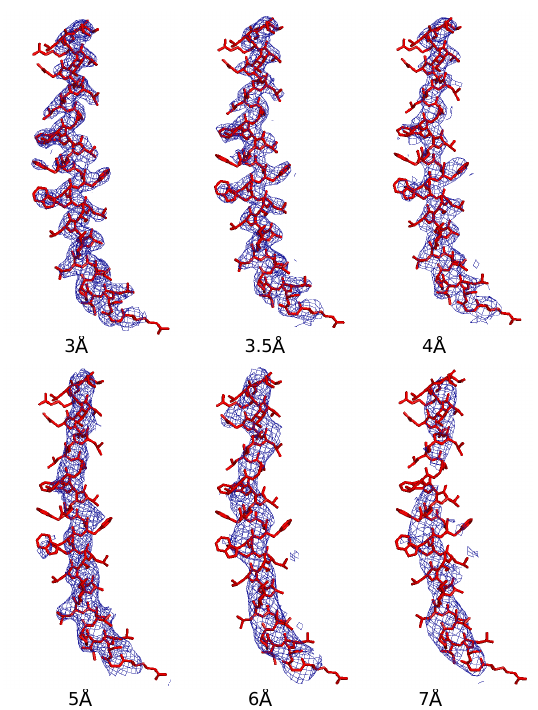
Figure 7. The calculated density maps of 2JLN using the 3, 3.5, 4, 5, 6, and 7 Å observed data. One major helix is presented for clarity. The PDB deposited model is displayed as red